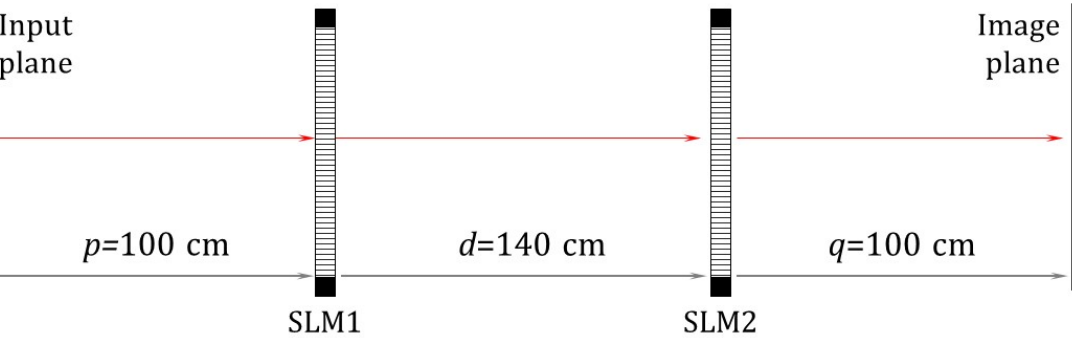
Figure 1. Schematic of the zoom lens optical system.